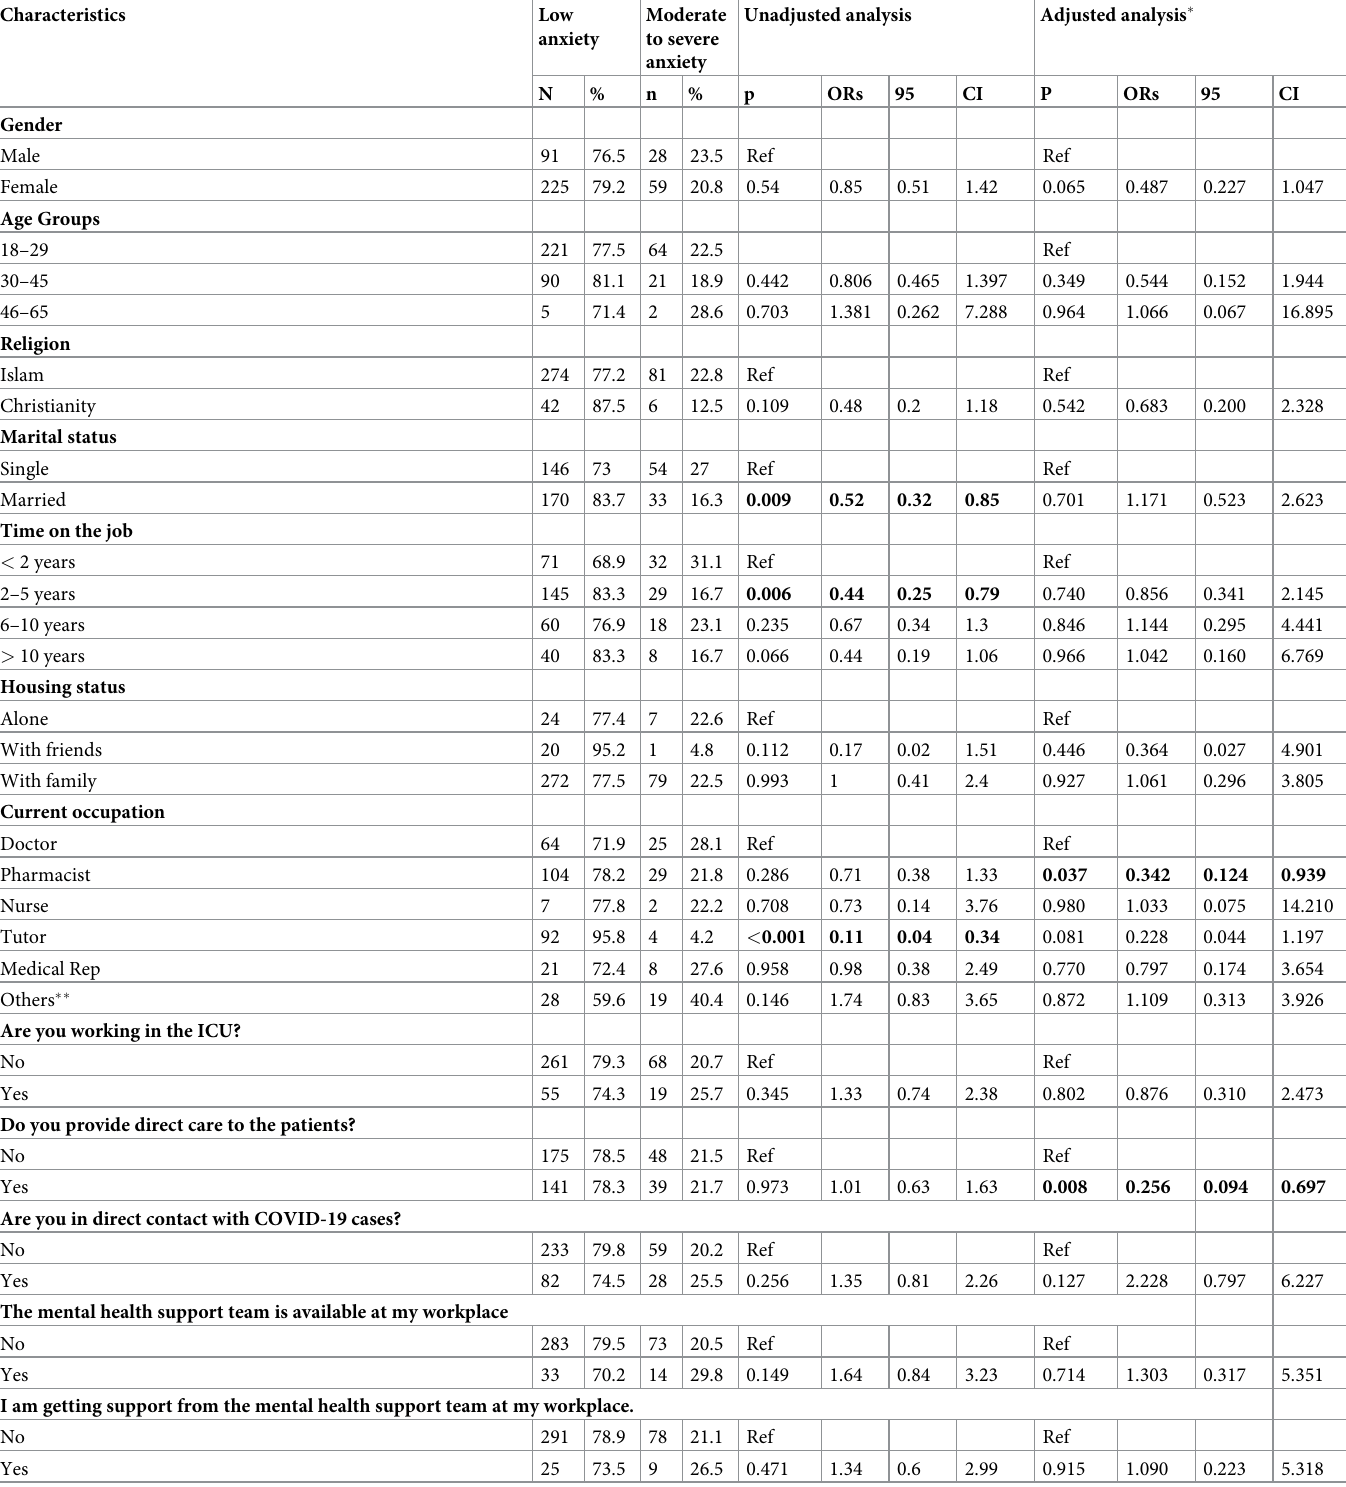
Table 2. Binary logistic regression explaining factors associated with higher anxiety among study participants.